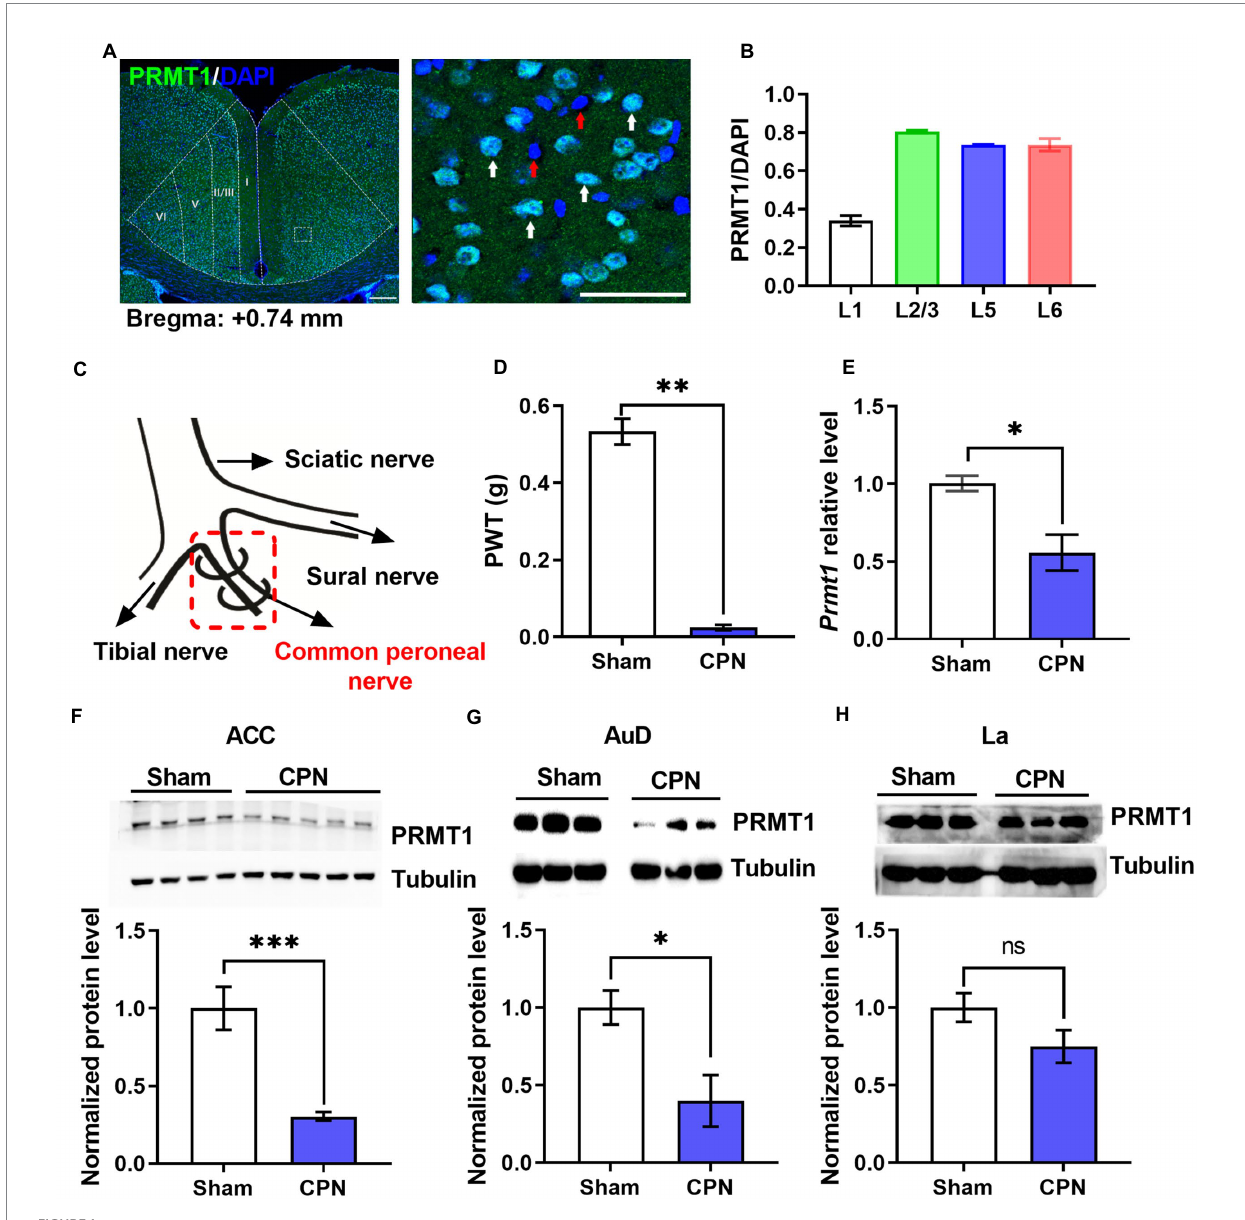
FIGURE 1 Peripheral nerve injury decreased PRMT1. (A) Left: representative photomicrograph of PRMT1 (green) in the anterior cingulate cortex (ACC). Right: zoomed-in view of the boxed region in the left panel. Blue: DAPI; green: PRMT1; red arrow: DAPI; white arrow: PRMT1 and DAPI; scale bars, 200 μ m (left), 50 μ m (right). (B) Quantification of PRMT1 positive cells in different layers of the ACC. (C) Schematic diagram of the ligation of the common peroneal nerve (CPN) in mouse. (D) Paw withdrawal thresholds (PWTs) assessed by von Frey behavioral test after common peroneal nerve (CPN) ligation (Sham and CPN, n = 6/group, unpaired t -test, p < 0.01; ** p < 0.01). (E) Prmt1 mRNA level in the ACC of Sham and CPN mice (Sham: n = 3, CPN: n = 3; unpaired t- test, p = 0.0237; * p < 0.05). (F) PRMT1 protein level in the ACC of Sham and CPN mice. Top: representative immunoblot images; bottom: statistical analysis (Sham: n = 4, CPN: n = 5; unpaired t- test, p = 0.0009; *** p < 0.001). (G) PRMT1 protein level in the auditory cortex (AuD) of Sham and CPN mice. Top: representative immunoblot images; bottom: statistical analysis (Sham: n = 3, CPN: n = 3; unpaired t- test, p = 0.039; * p < 0.01). (H) PRMT1 protein level in the lateral amygdaloid nucleus (La) of Sham and CPN mice. Top: representative immunoblot images; bottom: statistical analysis (Sham: n = 3, CPN: n = 3; unpaired t- test, p = 0.1453). Data are represented as mean ± SEM; ns, not